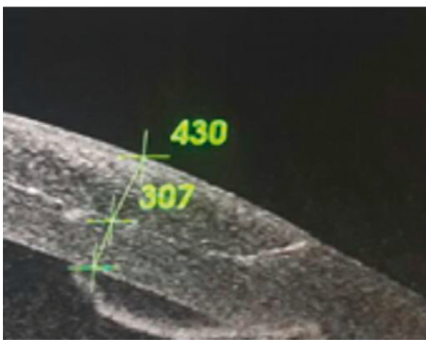
Figure 2: Showing excellent apposition at peripheral graft-host